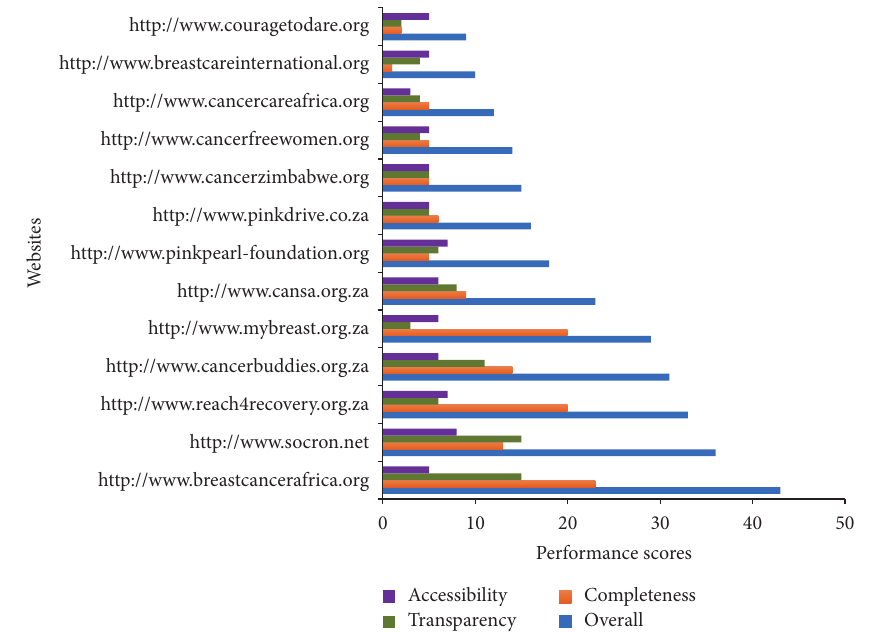
Figure 1: Performance of the websites (completeness, transparency, and